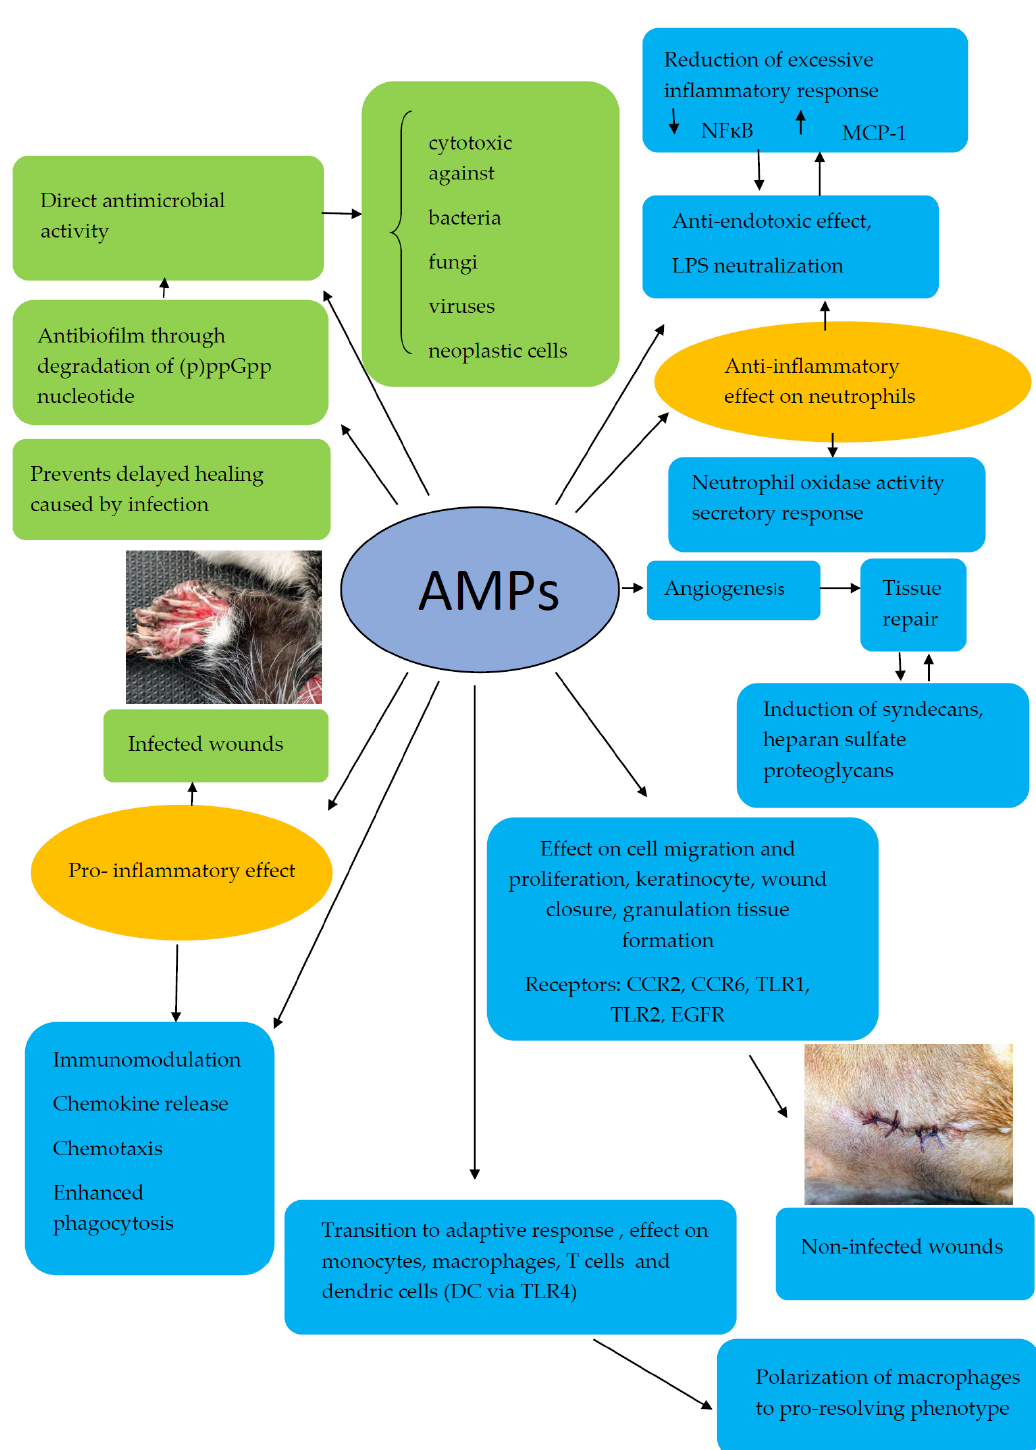
Figure 1. The pro- and anti-inflammatory effects of AMPs on different antimicrobial/cytotoxic activities (shown in green) and immunomodulatory/ tissue repair functions (shown in blue). There are two main groups of AMPs—cathelicidins and defensins. Defensins are classified as α -, β -, and θ -defensins. α -defensins 1–4 are present in the granules of neu- trophils, and α -defensins 5 and 6 are predominantly found in Paneth cells. β defensins (hBD) have been detected in different tissues. The constitutive expression of hBD 1 to 4